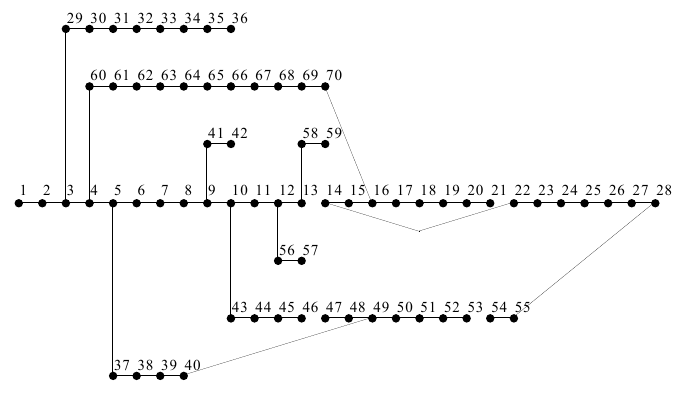
Figure 6. The topology of solution of Scenario IV.